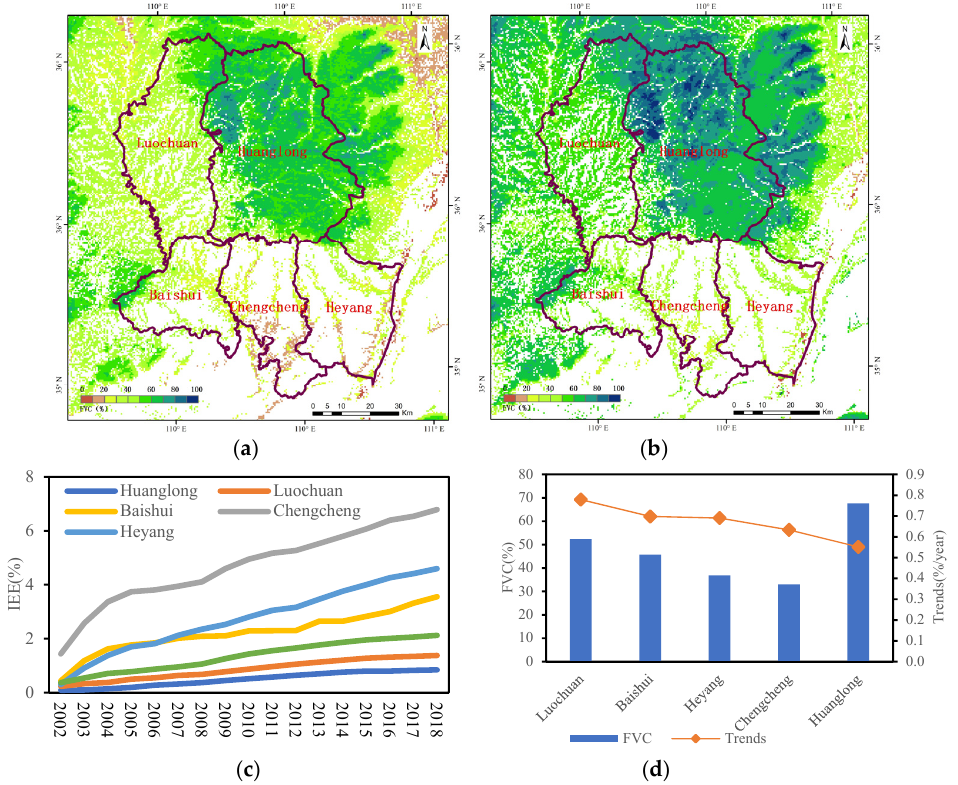
Figure 12. ( a ) is the 2000 year and the ( b ) is the 2019 year of the Spatial distribution of FVC in Huanglong and the typical area of the surrounding county. ( c ) The intensity of ecological afforestation (IEE) of each county in Huanglong and the surroundings. ( d )The FVC and trends of each county in Huanglong and the surroundings.